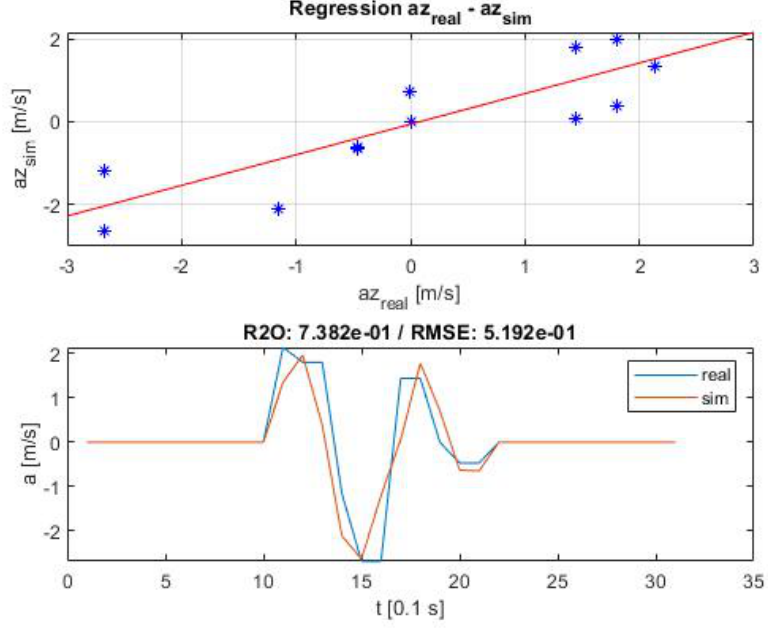
Figure A1. Validation of the z -acceleration in scenario 1 including ordinary R 2 and RMSE .